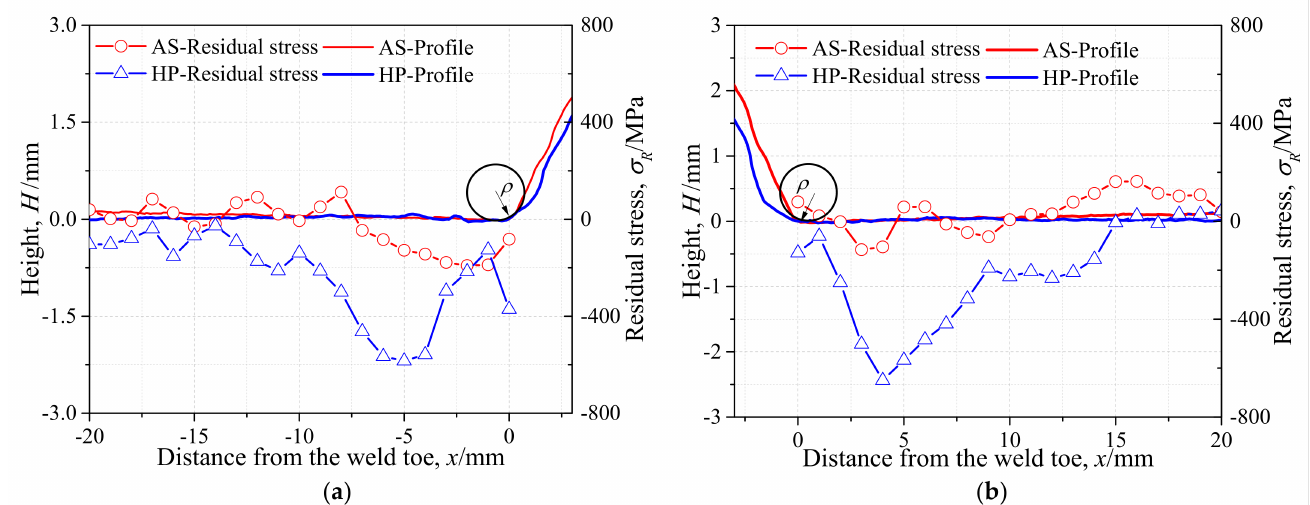
Figure 4. Angular distortion and residual stress in central axis X - X ’: ( a ) X side; ( b ) X ’